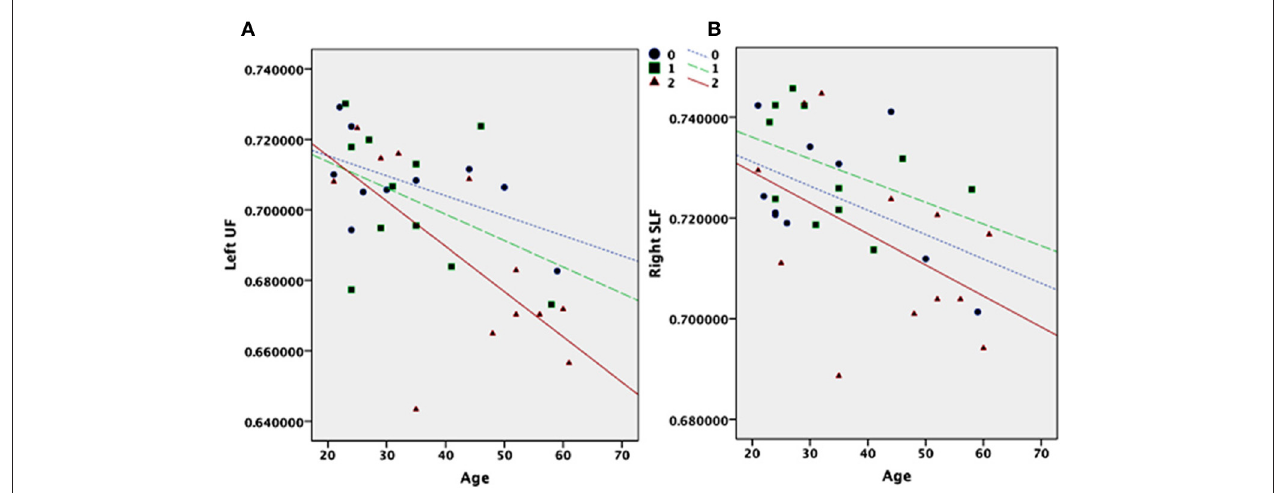
FIGURE 2 | FA values plotted for the number of short 5-HTTLPR copies (0 = LL; 1 = LS; 2 = SS) based on participants’ age for the frontal left UF (A) and the right SLF